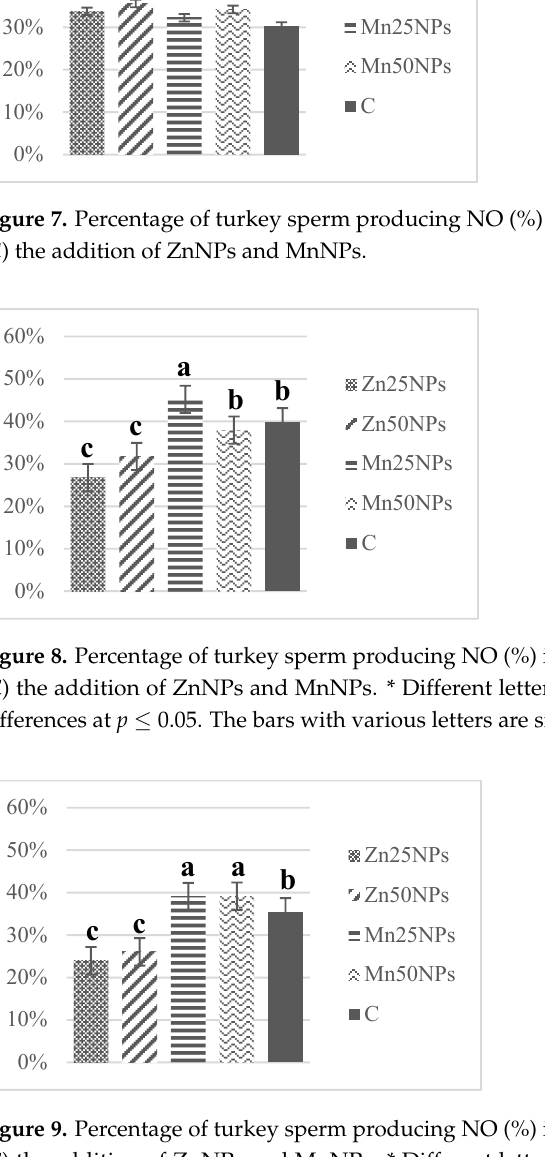
Figure 9. Percentage of turkey sperm producing NO (%) in samples stored for 48 h with or without (C) the addition of ZnNPs and MnNPs. * Different letters (a, b, c) indicate statistically significant differences at p ≤ 0.05. The bars with various letters are significantly different from one another.